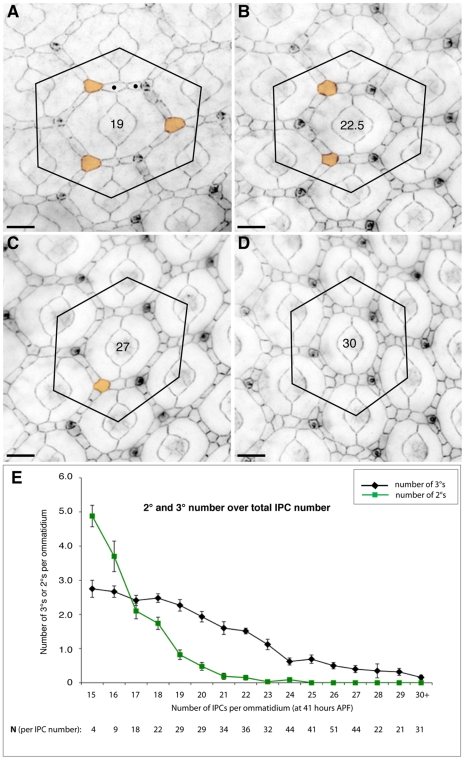
Inhibiting cell death impeded 2° and 3° formation in vivo.(A–D) Examples of ommatidia from GMR-Gal4/UAS-Diap1 retinae. For cell counts all IPCs lying within the hexagonal outline as drawn were counted; cells partly within the hexagon were counted as a half-cell. 3°s were defined as contacting three 1°s (colored orange); a correctly specified 2° locus was defined as one occupied by only one cell; examples of end-to-end 2°-like cells are labeled with •. Total cell count for each ommatidium is indicated at its center. Our analysis included only ommatidia surrounded by three correctly positioned bristle groups. Bars represent 10 µm. (E) Graph showing the decrease in 2° (plotted in green) and 3° (black) cell number as IPC number increased. The total number of ommatidia analyzed (N) per data point plotted is indicated below the y-axis.